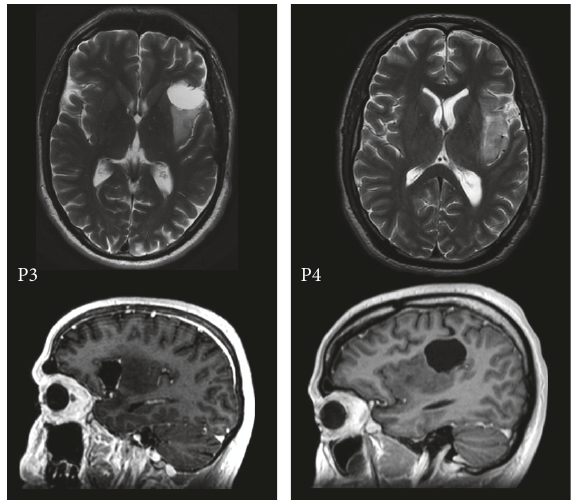
Figure 2: Postoperative MRI scans axial T2 weighted and sagittal T1 weighted P3 and P4.